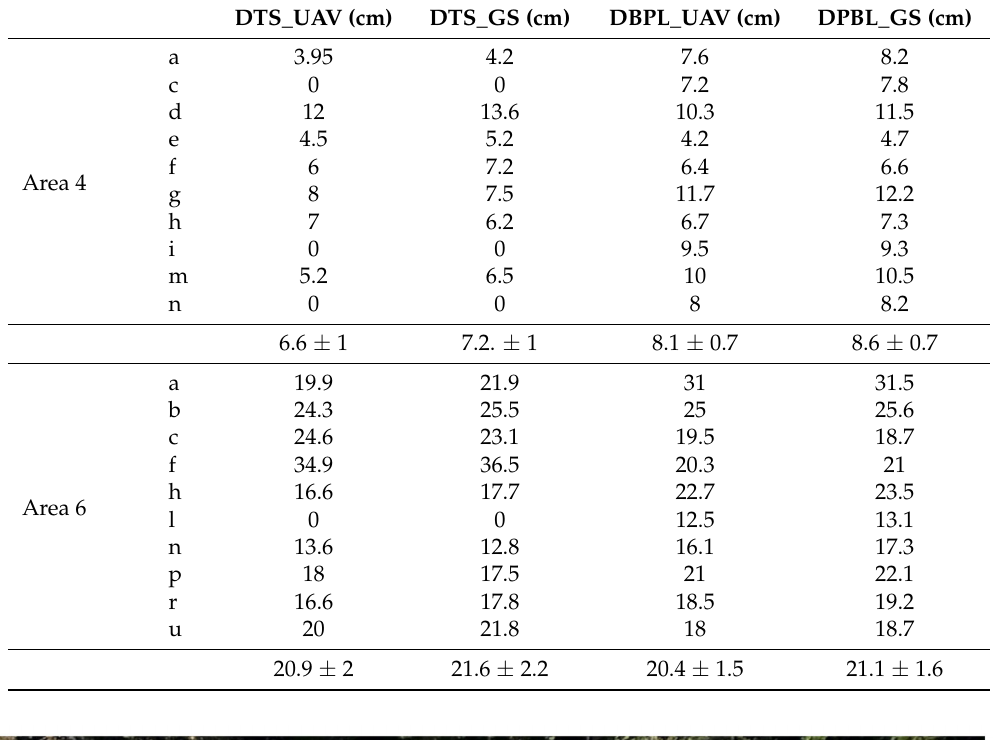
Table 2. Mean ( ± S.E.) of UAV measurements (_UAV) in comparison with ground survey measure- ments (_GS) (descriptive statistics): DTS = diameter of tree trunk (cork oaks); DBPL = diameter of burnt pine logs on the ground; lowercase letters of the first column are plots identifiers.